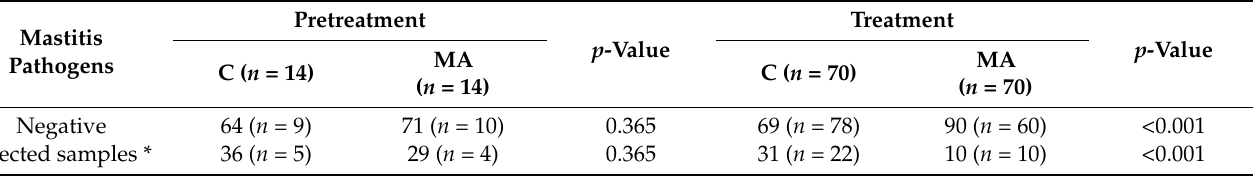
Table 3. Prevalence of udder pathogens in milk samples from different feeding treatments (%). Mastitis